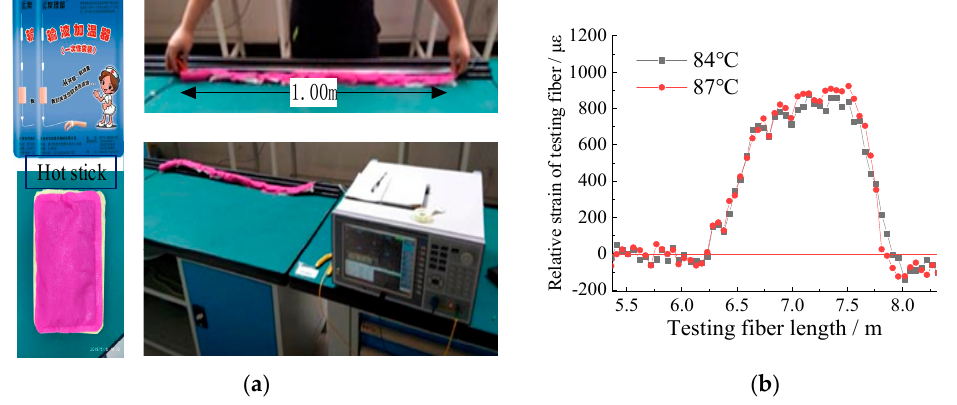
Figure 22. Optical fiber spatial position calibration test with BOTDR using hot deposition method. ( a ) shows the hot stick, test setup, and the test process; ( b ) shows the strain curve of the experiment. It is found that the strain change is not obvious when the length of hot deposit is less than 1 m.